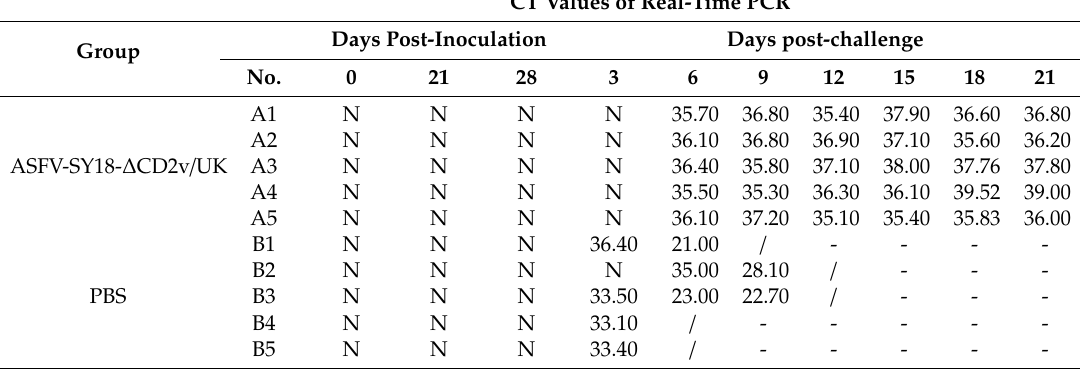
Table 3. Detection of ASFV genome in the nasal swab samples from the pigs following inoculation and challenge. CT Values of Real-Time PCR Days Post-Inoculation Days Group